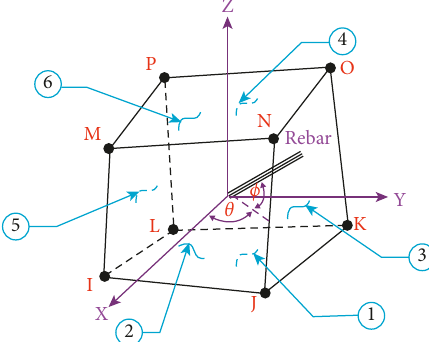
Figure 3: SOLID65 3D RC solid element